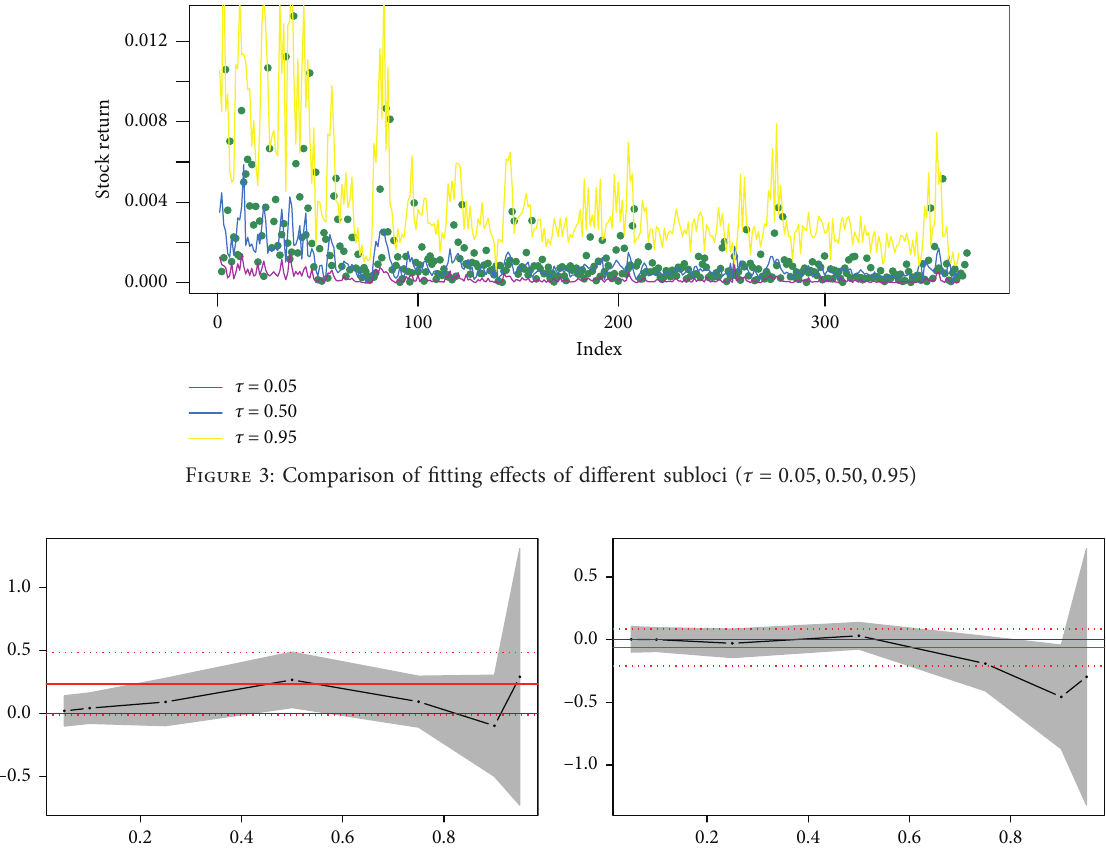
. (b) Under different loci 􏽢 λ 3 4 illustrates that there is a significant nonlinear relationship ( τ ) < 0, it 4